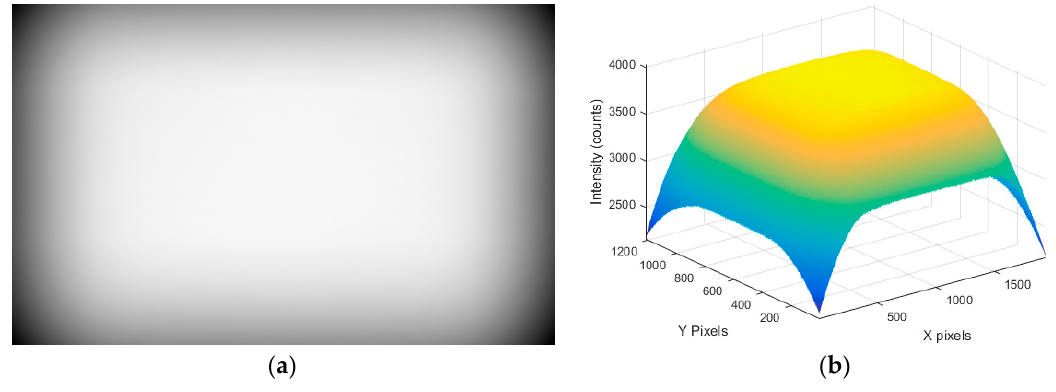
Figure 4. ( a ) Raw image from Genie Nano at 100% brightness and ( b ) surface visualisation of vignetting.